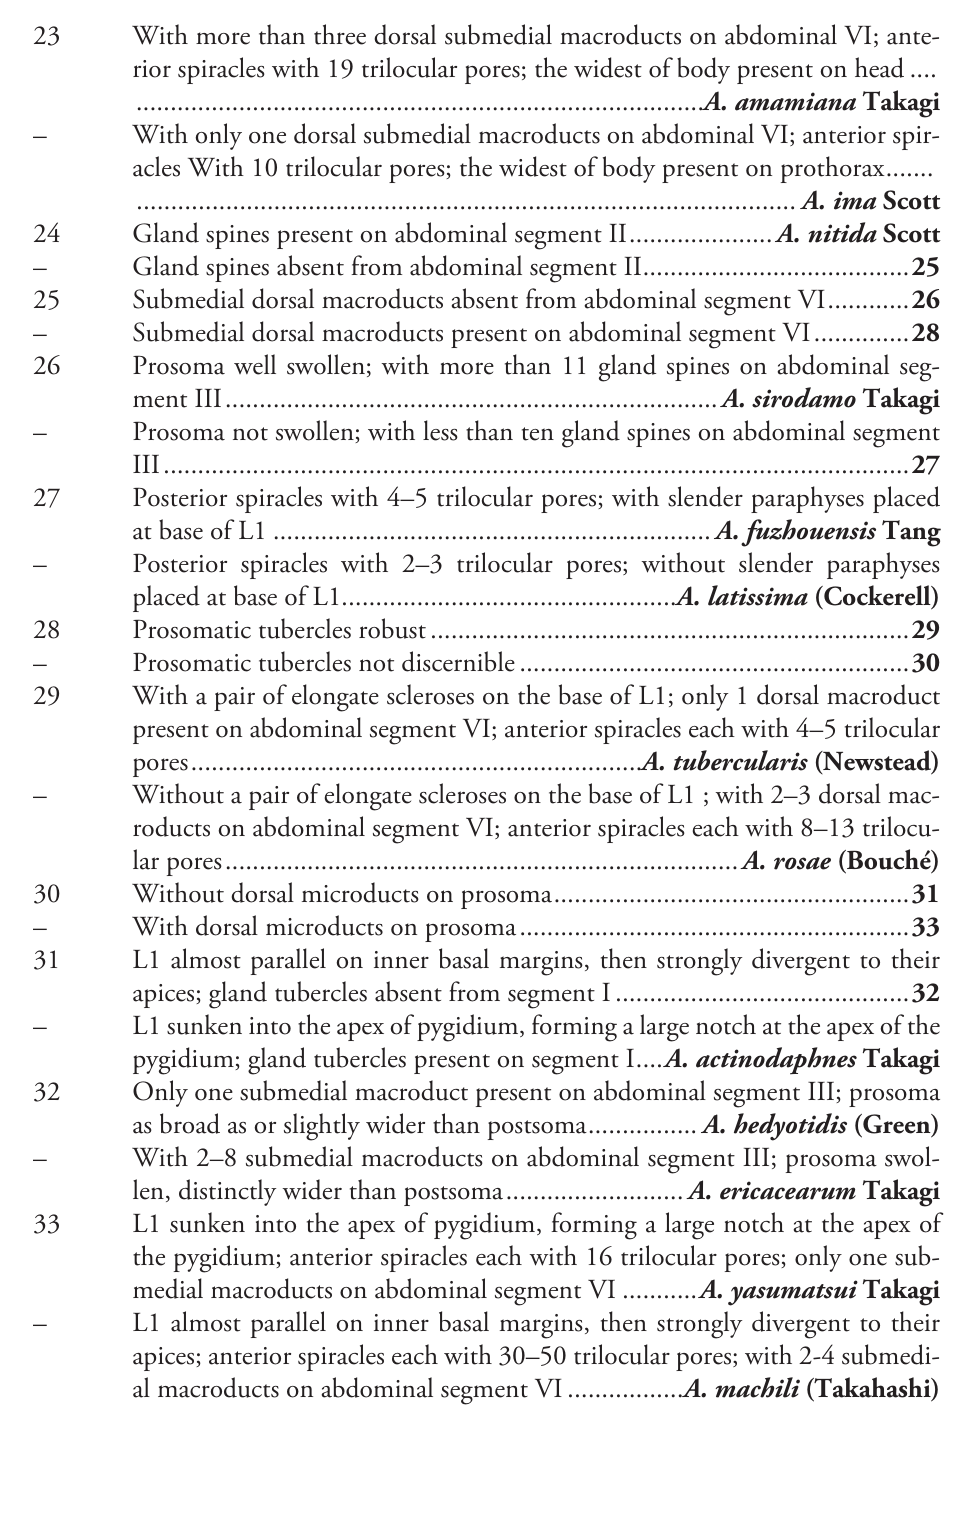
rior spiracles with 19 trilocular pores; the widest of body present on head